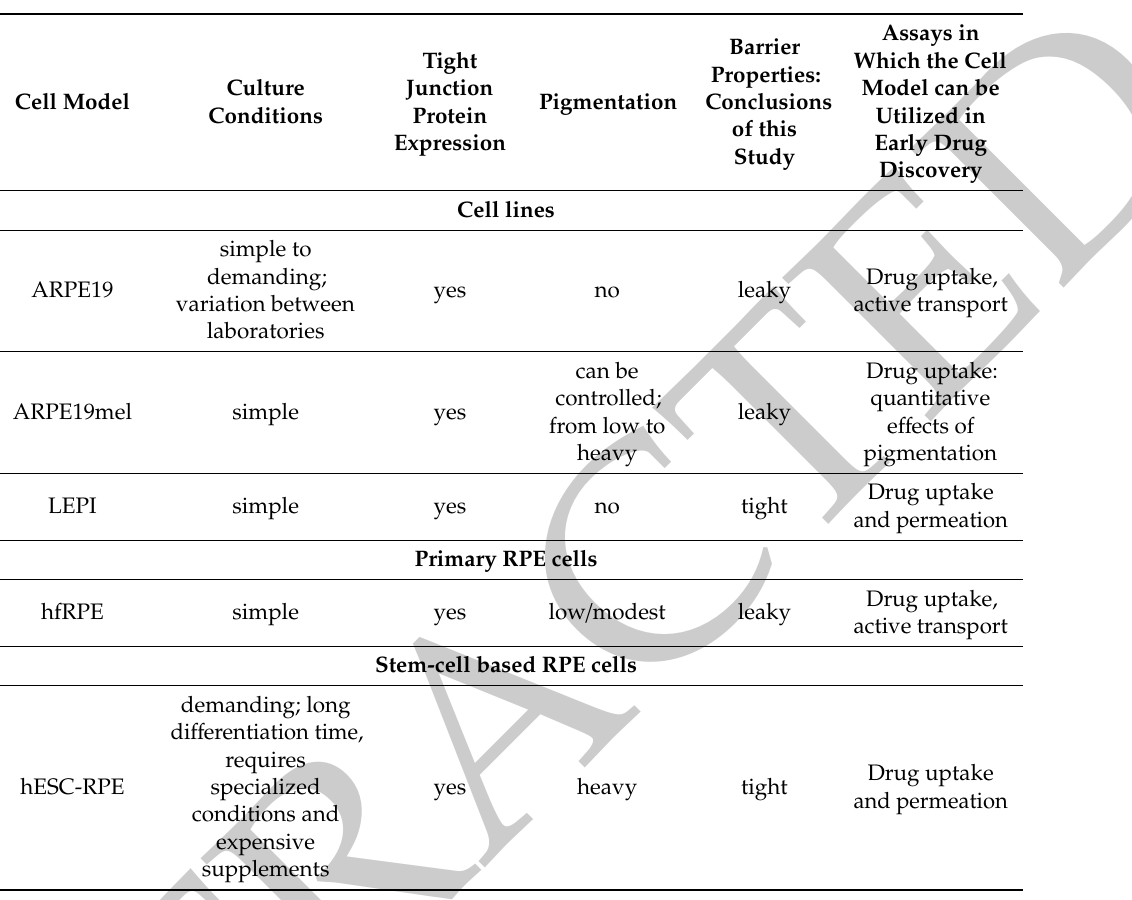
Table 3. Overview of the RPE cell model